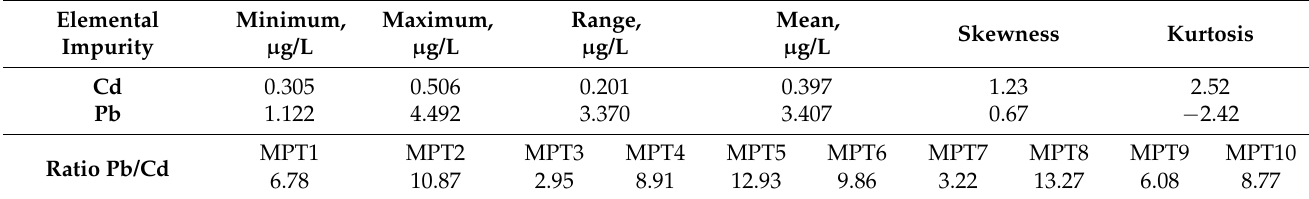
Table 3. The descriptive statistics of Cd and Pb impurities levels in analyzed HMP with Mentha × piperita L., folium.